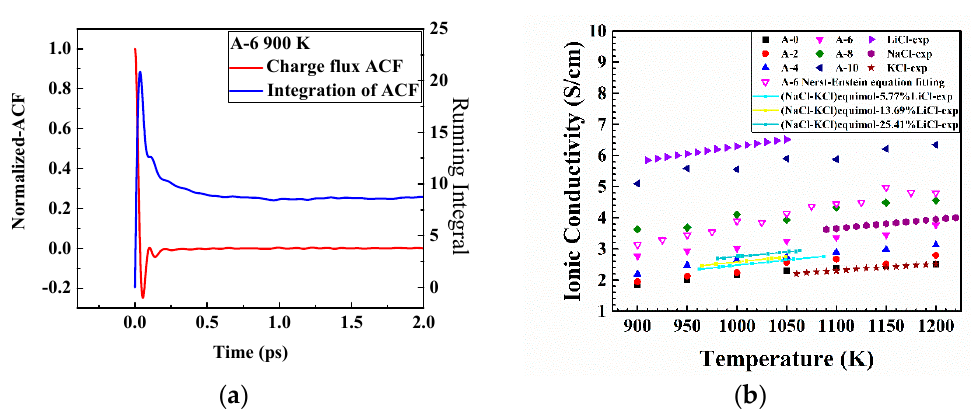
Figure 8. ( a ) Time evolution of the charge flux auto-correlation function (ACF) and the running integral for molten A-6 systems at 900 K. ( b ) The ionic conductivity of six typical systems compared with the pure salts experimental values [36] and Nerst-Einstein equation fitting [33].